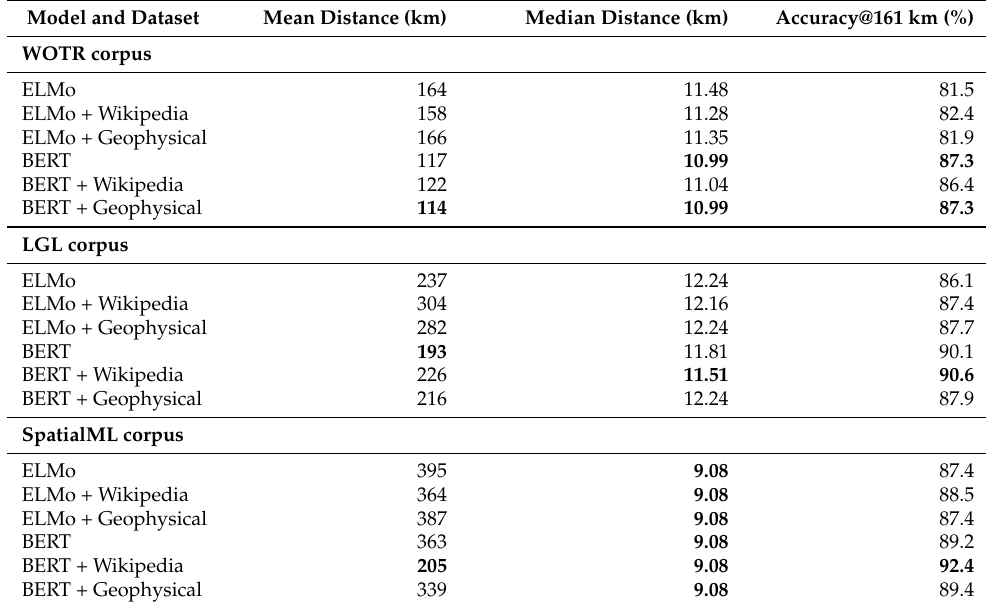
Table 3. Experimental results obtained with different modeling